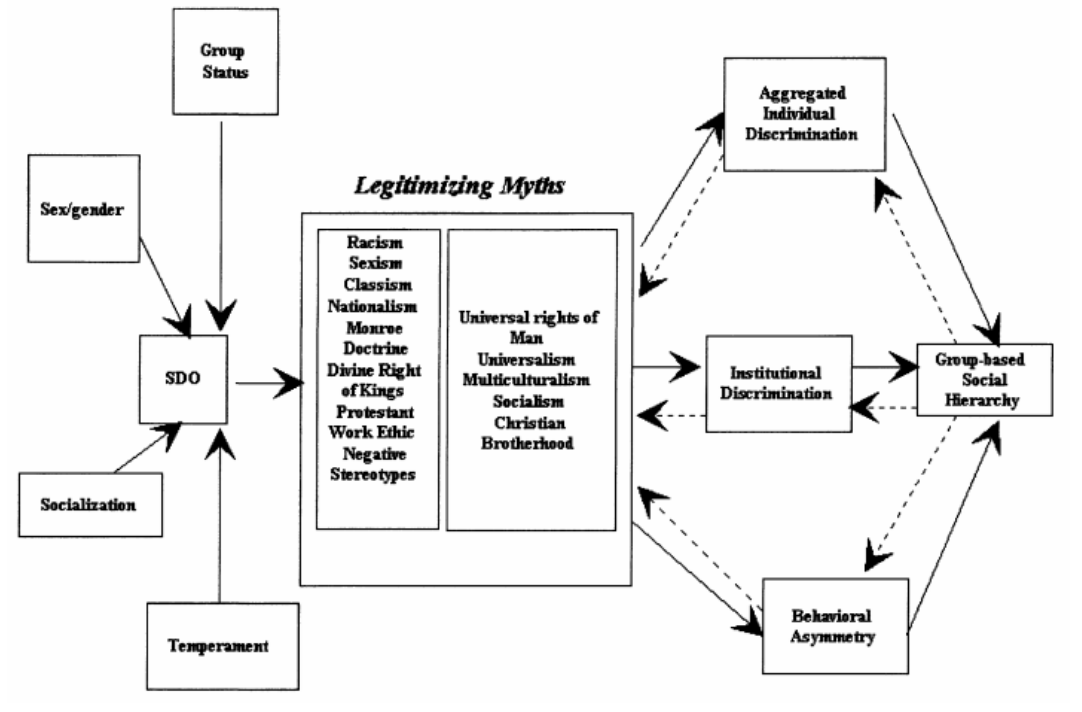
Figure 2: SDT schematic (Sidanius and Pratto, 1999)